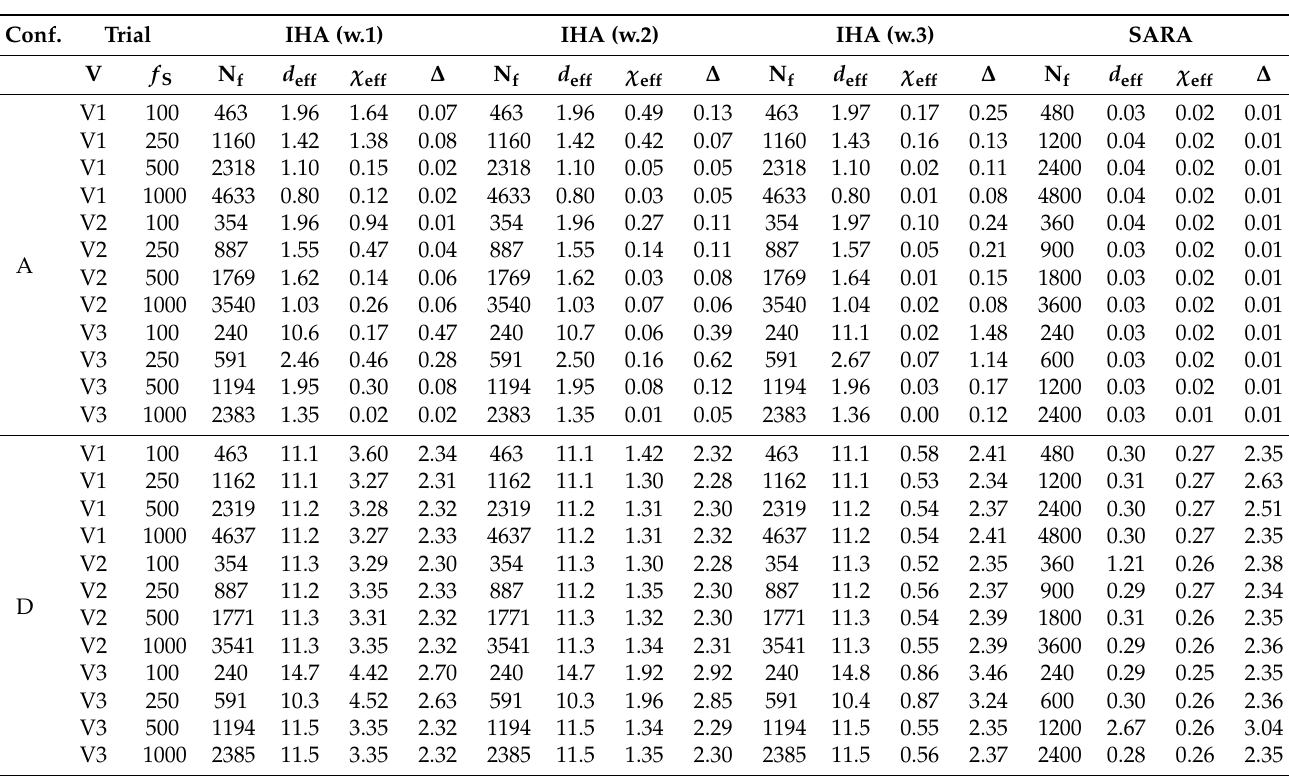
Table A3. Dispersion parameters ( d eff , in mm, and χ eff , in deg) and rms distance ( ∆ , in mm) between exact and estimated AoRs for different speeds and sampling frequency, in Hz, tested. Results are given for A and D motion configurations; the selected speed values (V1 . . . V3) are detailed in Section 2.3.4. For each algorithm, the resulting number of time frames N f is